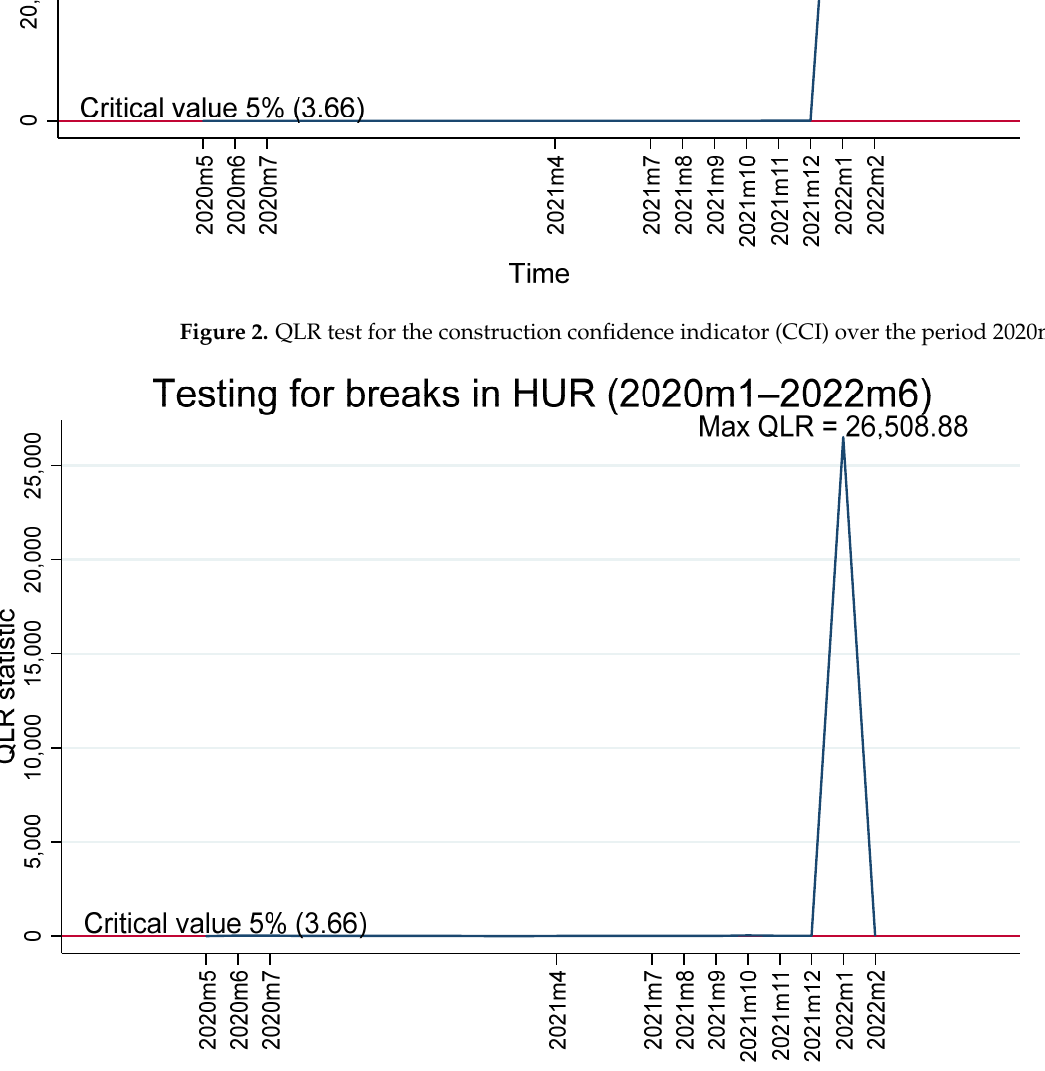
Figure 3. QLR test for the harmonized unemployment rates (HUR) over the period 2020m1–2022m6.